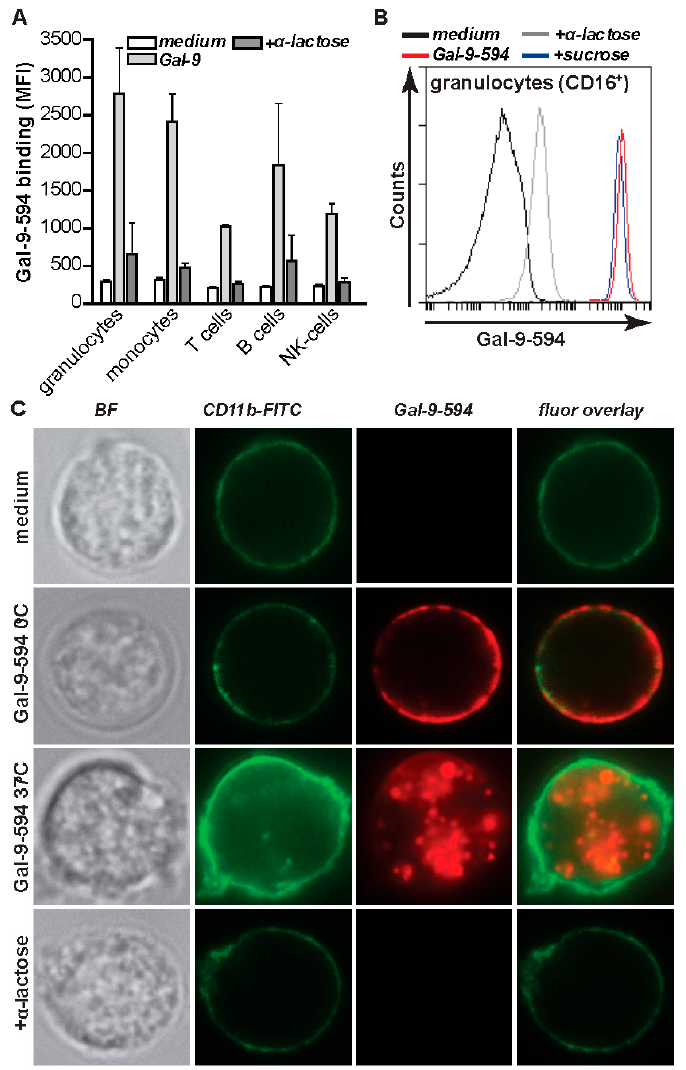
Figure 2. Gal-9 binds to granulocytes and other leukocytes in a lectin-dependent manner. ( A ) Binding of Gal-9-594 to peripheral blood leukocyte populations ( n = 2). Di ff erent populations were distinguished based on FSC / SCC and additional surface markers: CD16 (granulocytes), CD14 (monocytes), CD3 (T cells), CD20 (B cells), CD56 (NK cells). ( B ) Binding of Alexa-594-labelled Gal-9 (Gal-9-594) to granulocytes as determined by fluorescent microscopy (with CD11b-FITC co-staining) and flow cytometry in the presence or absence of competitive inhibitor α -lactose (40 mM) or the irrelevant carbohydrate sucrose. ( C ) Binding and internalization of Gal-9-594 ( +/ − α -lactose, 40 mM) to granulocytes (counterstained with CD11b-FITC) at 0 and 37 ◦ C visualized by fluorescent microscopy (representative picture of two independent experiments). Mag. × 100; cell diameter ~12 µ